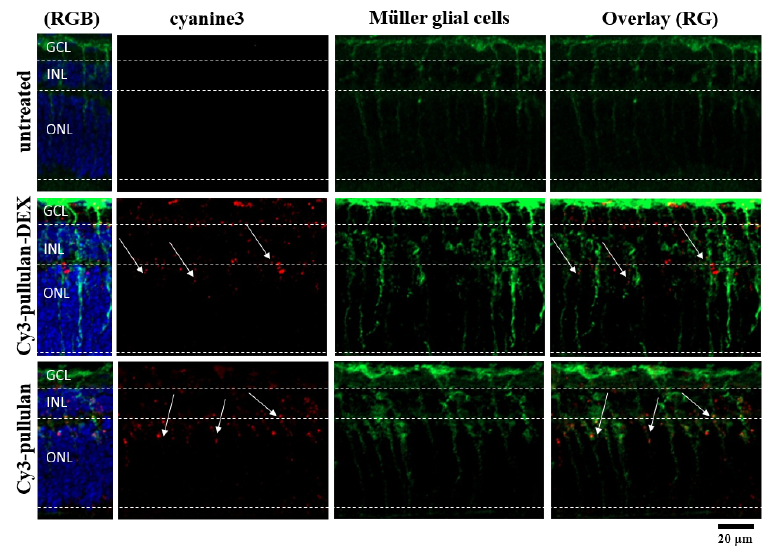
Figure 12. Müller glial cells in sections of the ex vivo mouse retina labelled with an antibody against glutamine synthetase (green). Untreated retina, retina treated with Cy3-pullulan-DEX (15 μ L, 1.9 mg/mL) and Cy3-pullulan (15 μ L, 1.7 mg/mL) are shown. Cy3 fluorescence is shown as red. Nuclei were stained with DAPI (blue). RG: overlay of red and green channels for Müller glial cell, nano- particle or conjugate colocalization. RGB: overlay of red, green and blue channels. Bar size: 20 μ m. The retinal distribution of pullulan conjugates was also studied in ex vivo bovine retinal explants. In this tissue model, the nanoparticles were mainly localized at ILM. However, several sections showed a few signals (green punctas) from BDP-pullulan-DEX in GCL of the retina (Figure 13).